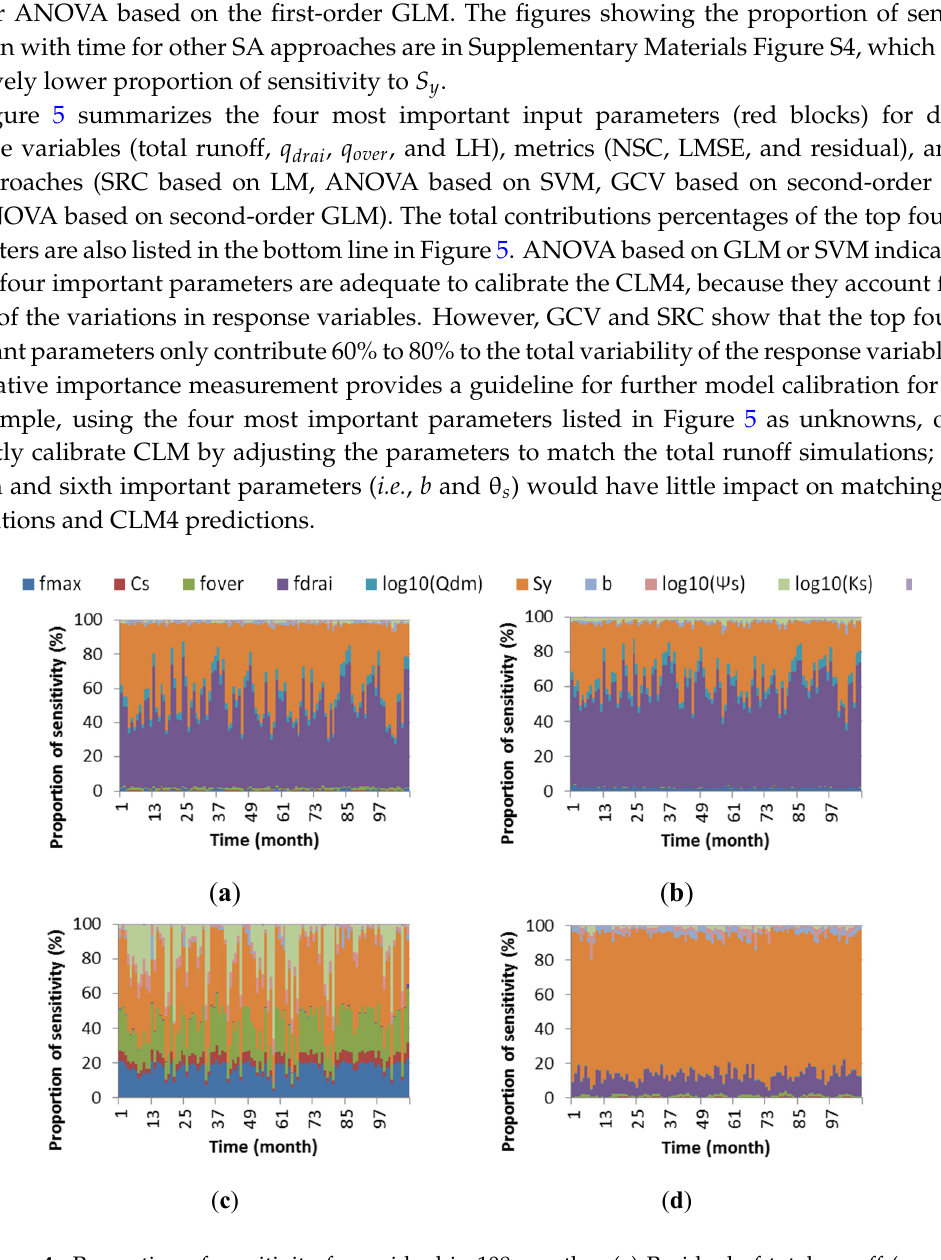
Figure 5. The four most important input parameters (red blocks) for different response variables (total runoff, (cid:1869) (cid:3031)(cid:3045)(cid:3028)(cid:3036) , (cid:1869) (cid:3042)(cid:3049)(cid:3032)(cid:3045) , and LH), metrics (NSC, LMSE, and residual), and four SA approaches (SRC based on LM, ANOVA based on SVM, GCV based on second-order MARS, and ANOVA based on second-order GLM). 3.3. Convergence, Under-Sampling Issues, and Model Verification As mentioned in Section 3.2, different SA approaches may lead to different important measurement results for input parameters. Moreover, the convergence speed of the SA approach may vary, and the SA approach with higher convergence speed is always preferred. The convergence speed also varies with different response variables. Figure 6 shows the comparison of the convergence of sensitivity scores for different response variables (NSC of total runoff, (cid:1869) (cid:3031)(cid:3045)(cid:3028)(cid:3036) , (cid:1869) (cid:3042)(cid:3049)(cid:3032)(cid:3045) , and LH) and SA approaches (ANOVA based on first-order GLM and GCV based on first-order MARS). The convergence curves for LMSE and second-order regression models are shown in Figure